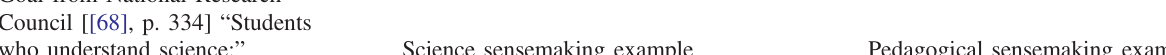
TABLE I. The four primary learning goals articulated in the NRC 2007 report Taking Science to School [68]; examples from the literature of science sensemaking activities that would support each goal; and analogous examples from the teacher education literature of pedagogical sensemaking activities that would support these same goals in the context of